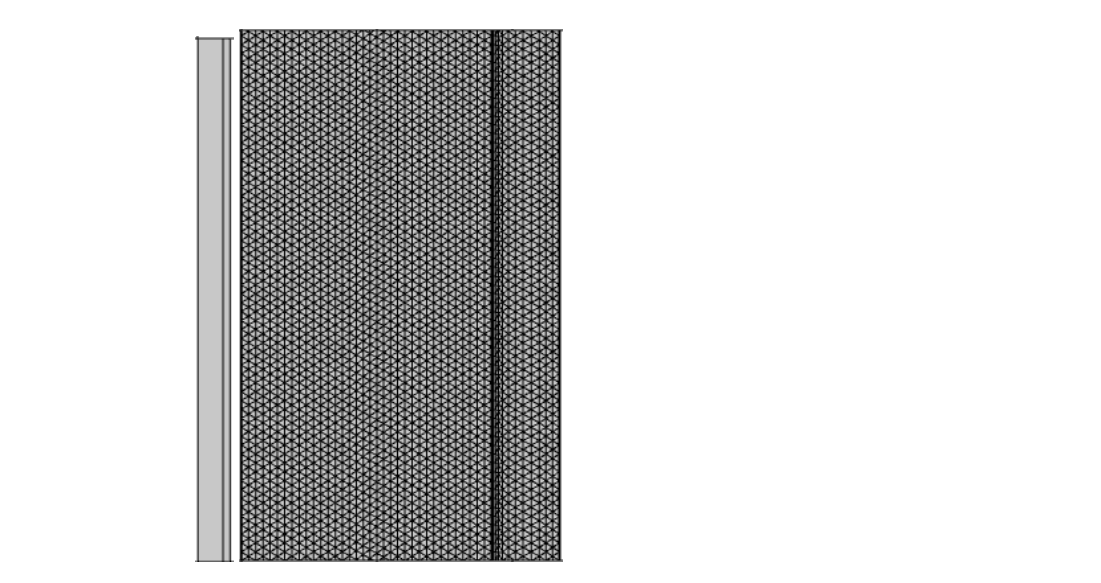
Figure 11. Computational domain of a 2D half-cell of the U-shaped coil and the divided mesh.